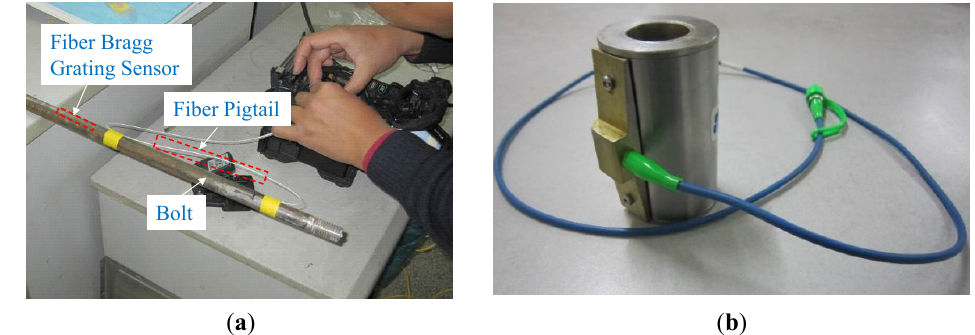
Figure 4. Encapsulated FBG force-measuring bolt picture ( a ); FBG dynamometer picture ( b ).